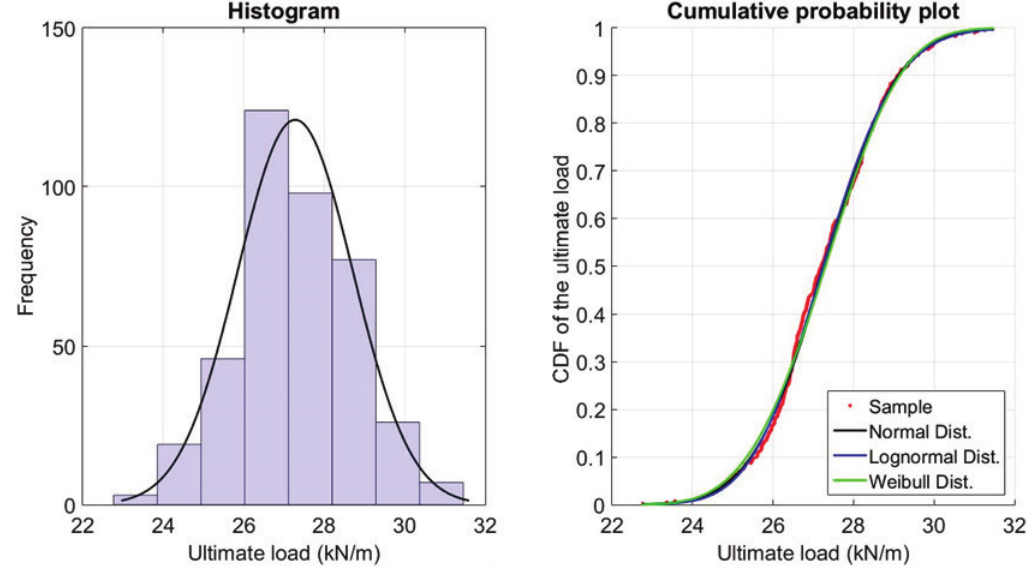
Distributions fitness for resistance of the beam V-25-40-r-15 (400